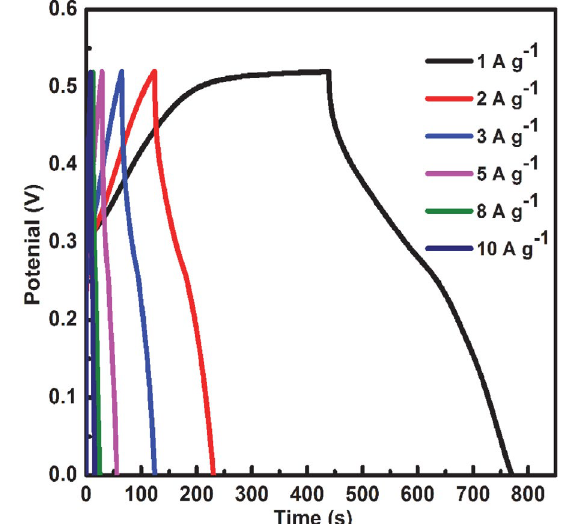
Fig. 9. Charge-discharge curves of the 0.25 mmol Cu 2+ -doped MnO 2 electrode at different current